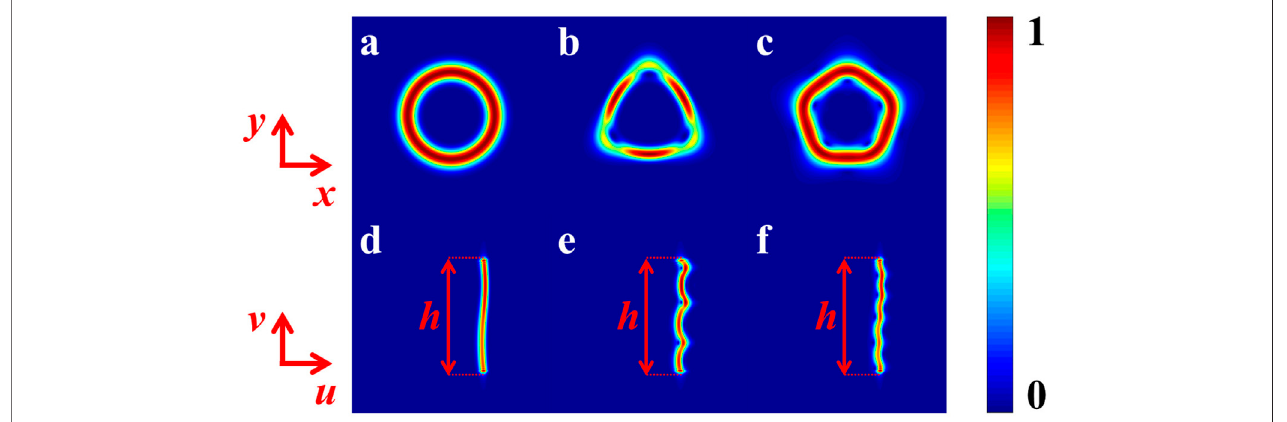
FIGURE 1 | Intensity distribution ofpolygon OV beams: (A) circular, (B) triangle, and (C) pentagon. (D – F) Linear OVbeams with kinked distribution corresponding to (A – C) .